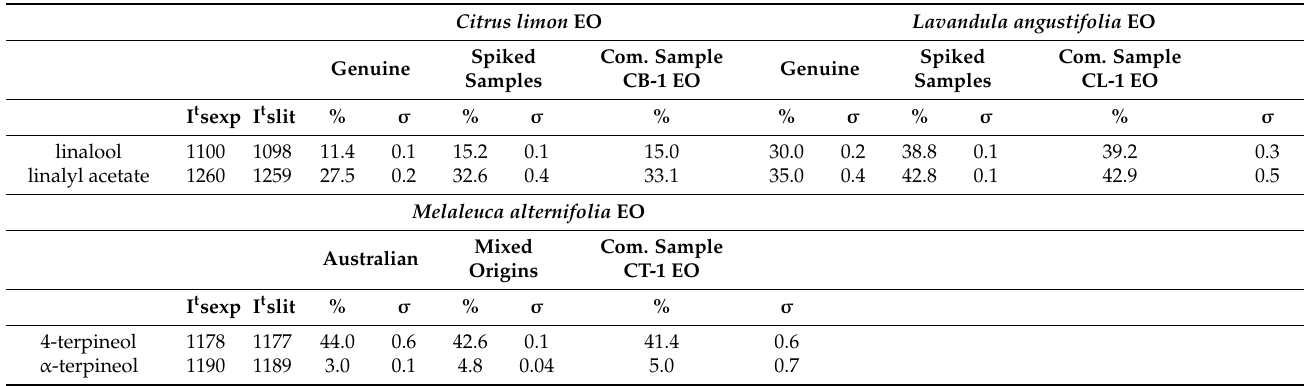
Table 3. Normalised relative % abundance of linalool, linalyl acetate, 4-terpineol and α -terpineol in genuine, spiked and commercial samples of bergamot, lavender and TTO EO obtained with conventional